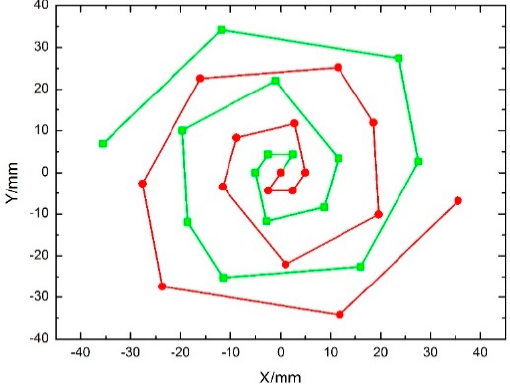
Figure 5. Double-helix-ultrasonic-array.